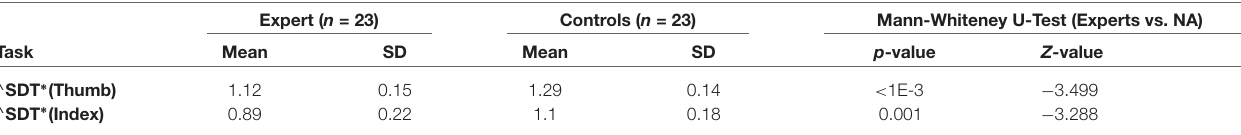
TABLE 1 | Psychophysical measurement of tactile ability in the acupuncturist and NA groups . Expert ( n = 23) Controls ( n = 23) Mann-Whiteney U-Test (Experts vs. NA) Task